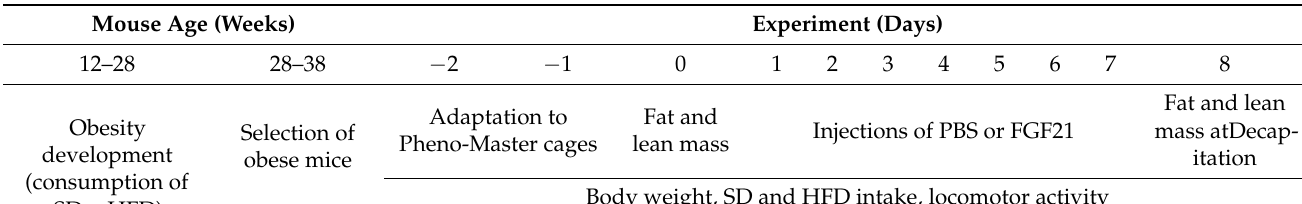
Table 3. Experimental